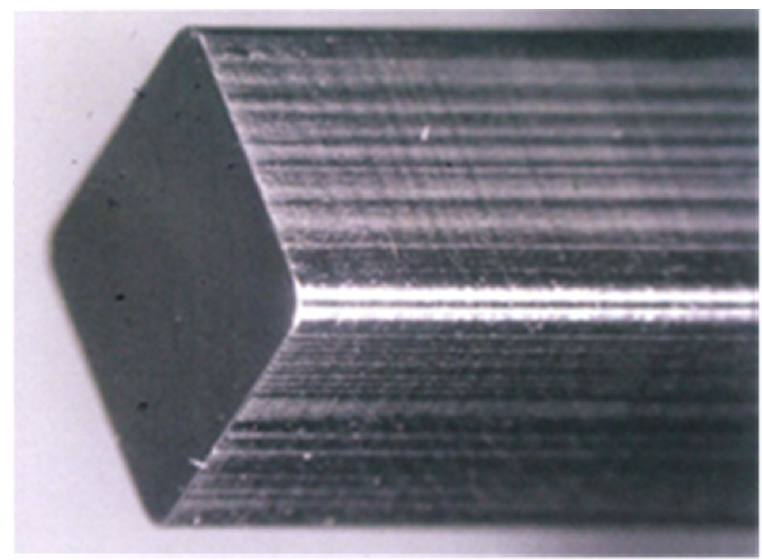
Figure 3. High ‐ speed steel type YXR7 punch for fine blanking the square hole. Figure 3. High-speed steel type YXR7 punch for fine blanking the square